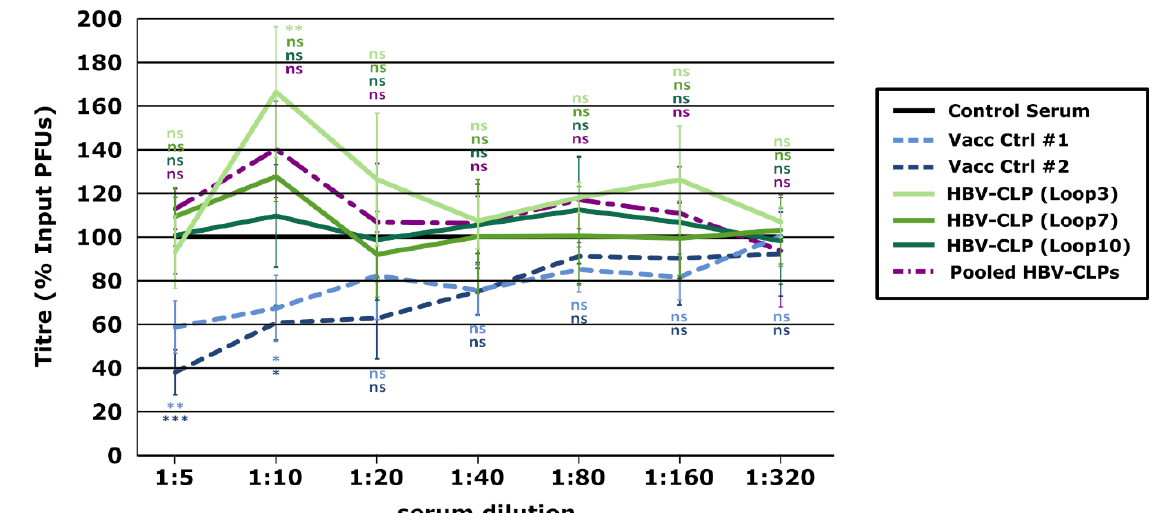
Figure 8. Assessment of neutralizing antibody development following vaccination with hepatitis B virus core-like particles (HBV-CLPs) expressing Junín virus (JUNV)-derived peptides based on the plaque reduction neutralization test. JUNV (strain Cba IV4454) diluted to 10 3 pfu/mL was mixed 1:1 with serum from rabbits vaccinated with 1 of the HBV-CLPs indicated (Loop 3, Loop 7, or Loop 10), a pooled mixture of the sera from these rabbits, or serum from a rabbit that received a control HBV- CLP containing a FLAG peptide. Serum from human Candid#1 vaccinees (Vacc Ctrl) or a control pooled human AB serum served as additional controls. Samples were incubated for 1 h at 37 °C before 100 μ L were used to infect Vero cells for analysis using the plaque assay. Values are expressed as a percentage of the number of plaques in samples treated with the control serum (i.e., HBV-CLP- FLAG or human AB serum). Data from at least two independent experiments are represented and the results of a one-way ANOVA comparison of the experimental samples with the control antibody are shown (ns not significant; * p ≤ 0.05; ** p ≤ 0.01; *** p ≤ 0.001).